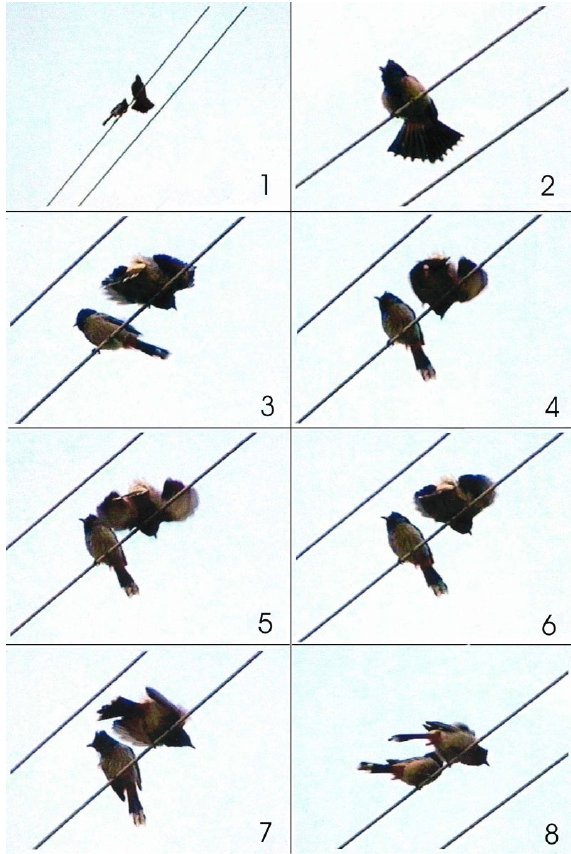
Image 2. Sequential components and structural elements (1 to 8) of Mate Acquisition Display in Red-vented Bulbul.